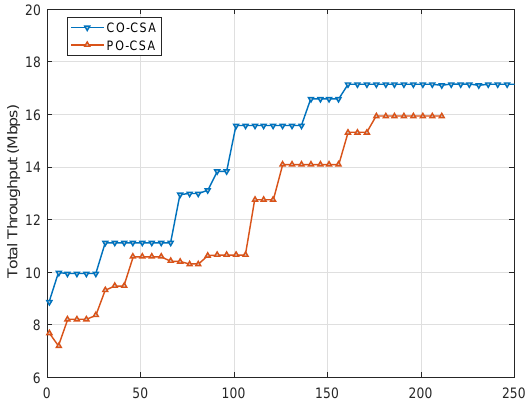
Figure 3. Convergence curve of the proposed approach with different